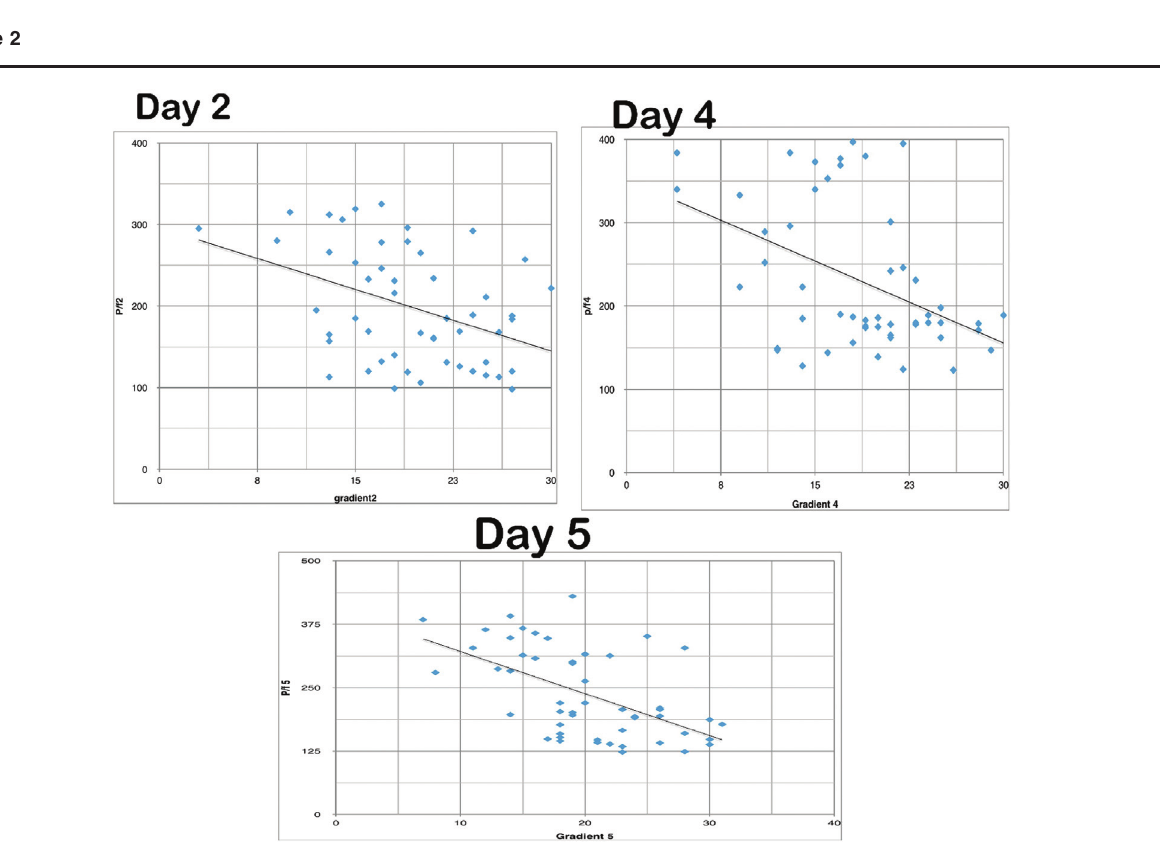
P / F and gradient correlation on days 2, 4, and 5 of the